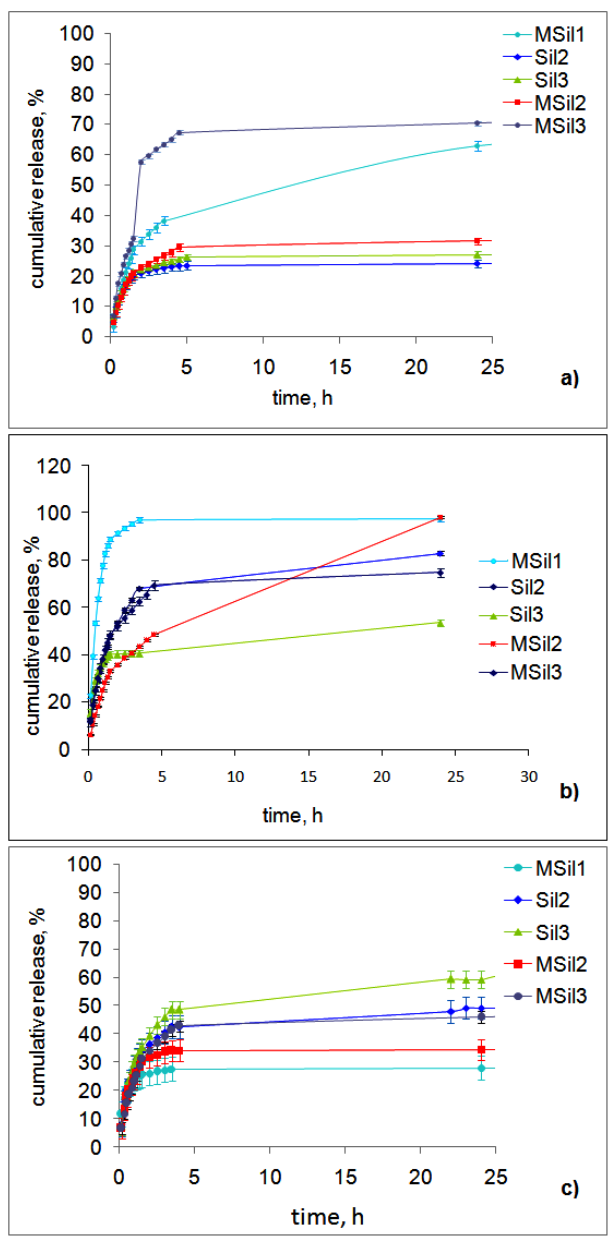
Figure 8. Dox release profiles of the silica materials at: pH 7.4 ( a ), pH 5 ( b ) and pH 2.6 ( c ). Two mathematical models were used to analyze the drug release kinetics: Higuchi (Equation (5)) [32] and the Korsmeyer–Peppas equation (Equation (6)) [33]. Both models